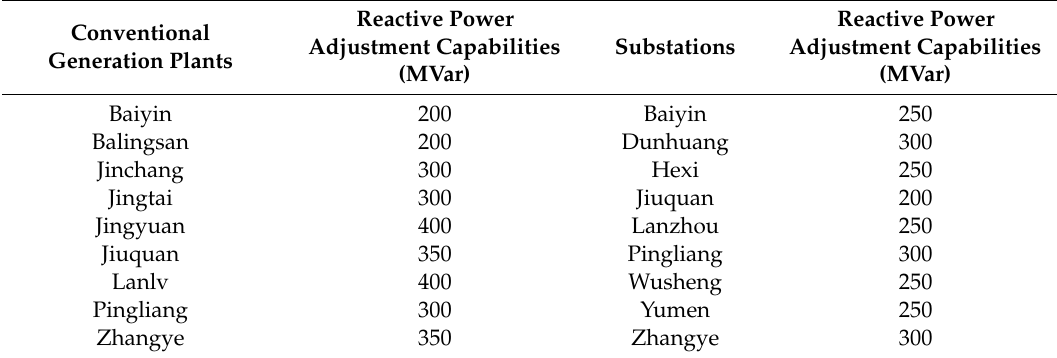
Table 1. Reactive power adjustment capabilities of conventional generation plants and substations (sorted by the first letter of names).